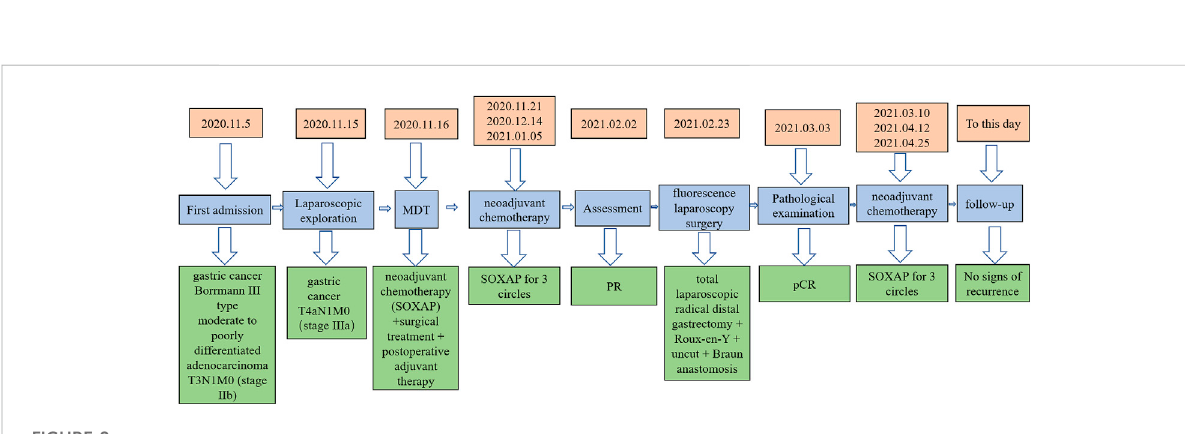
FIGURE 8 The timeline of the patients ’